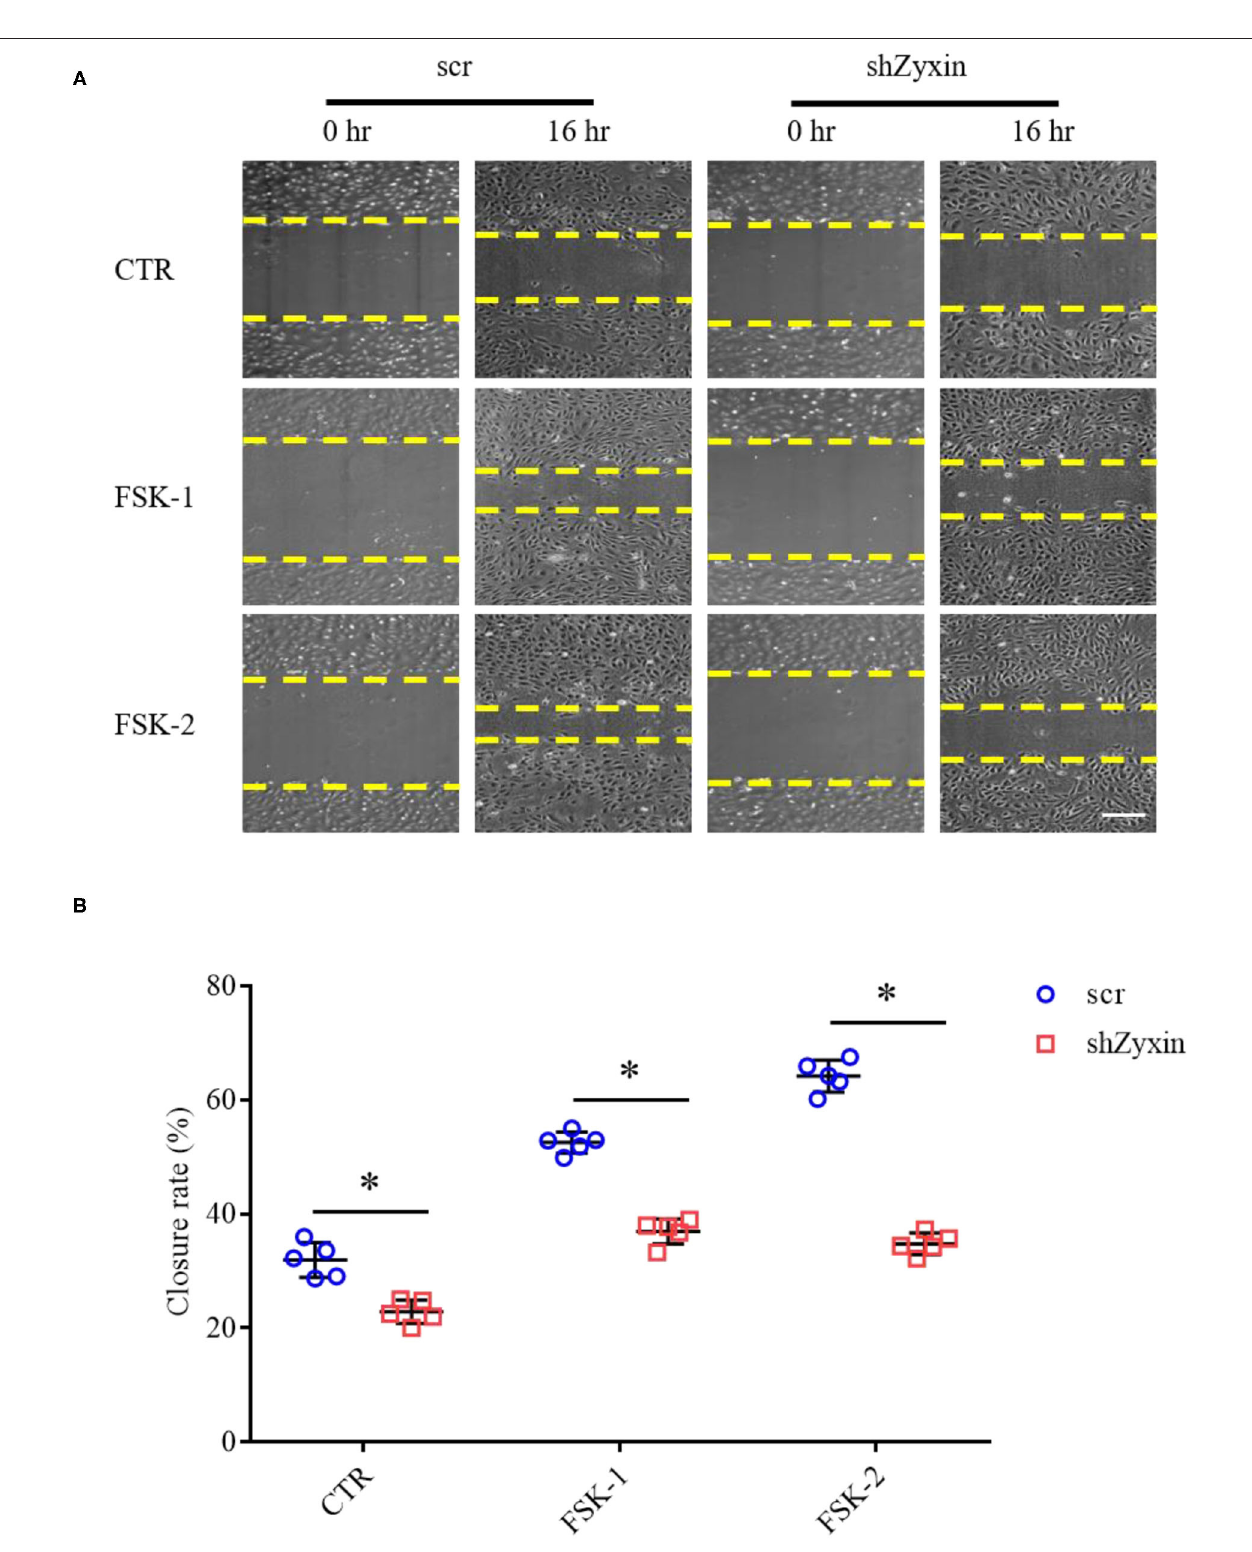
FIGURE 6 | Zyxin deletion in HUVECs decreases migration under forskolin stimulation. (A) Representative images of the effect of zyxin on HUVEC migration under forskolin (FSK) stimulation assessed by a scratching wound-healing assay 0 and 16h post scratching (scale bar, 500 µ m). HUVECs expressing scrambled shRNA (scr) or zyxin shRNAs (shZyxin) were stimulated with two concentrations of forskolin (FSK-1: 1 µ M, FSK-2: 5 µ M) or vehicle (CTR). (B) Quantification of mean closure rate 16h after scratching. Mean ± SD, n = 5, * P < 0.05. Test of normality: P > 0.05, test of homogeneity: P > 0.05.